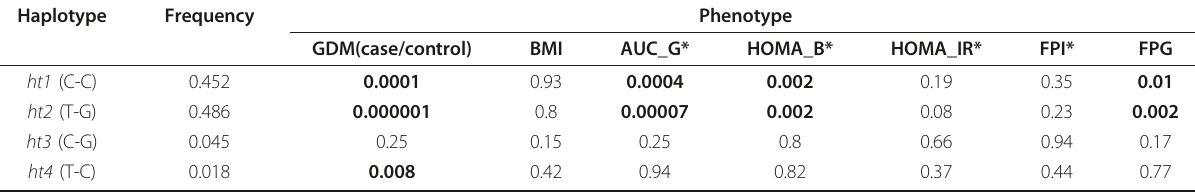
Table 3 Haplotype association analyses with GDM and GDM-related